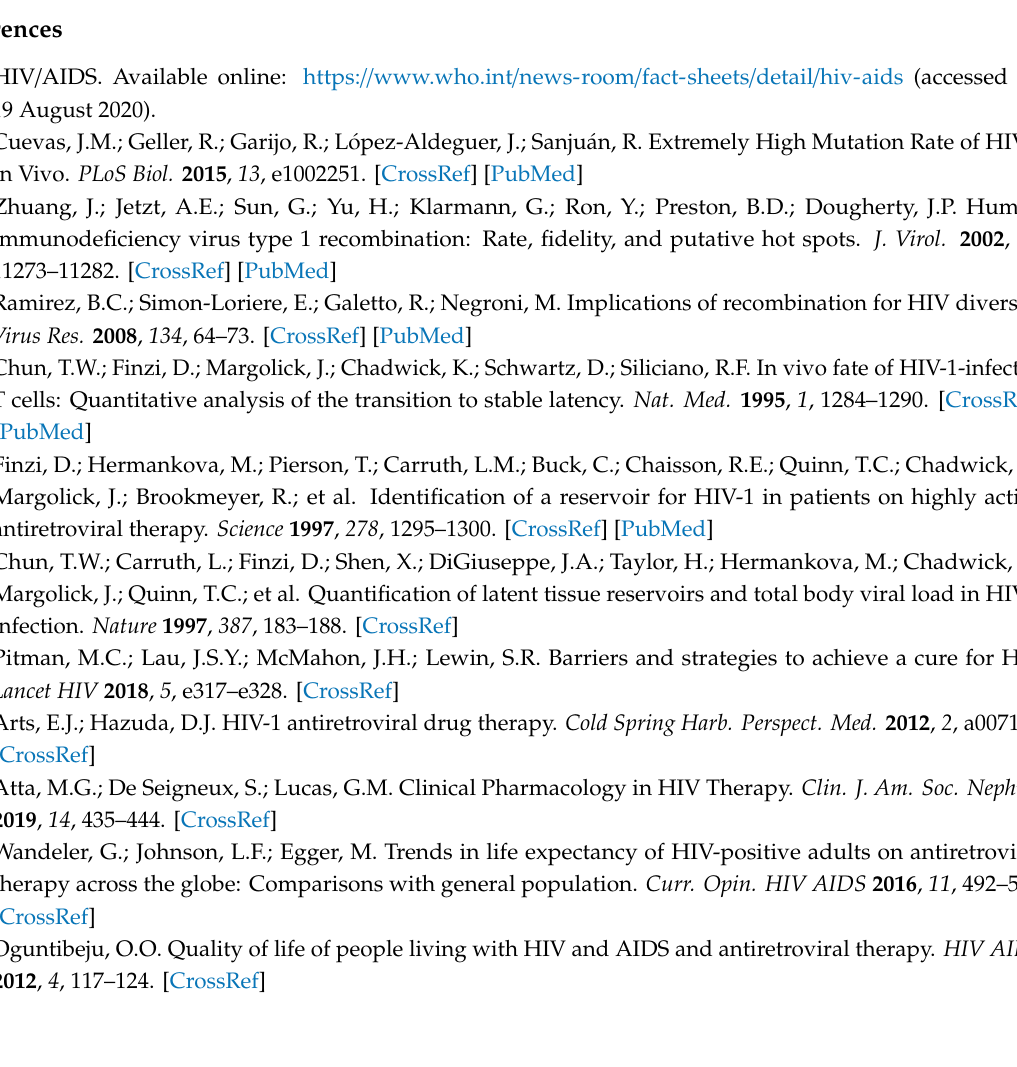
Table S1: Overview of the selected gp120 HIV-1 strains from a diversity of clades, Table S2: Sensitive and resistant strains towards three anti-CD4bs antibodies. Figure S1: Experimental IC50 determinations of VRC01 sensitive strains. Figure S2: Experimental IC50 determination of VRC01 resistant